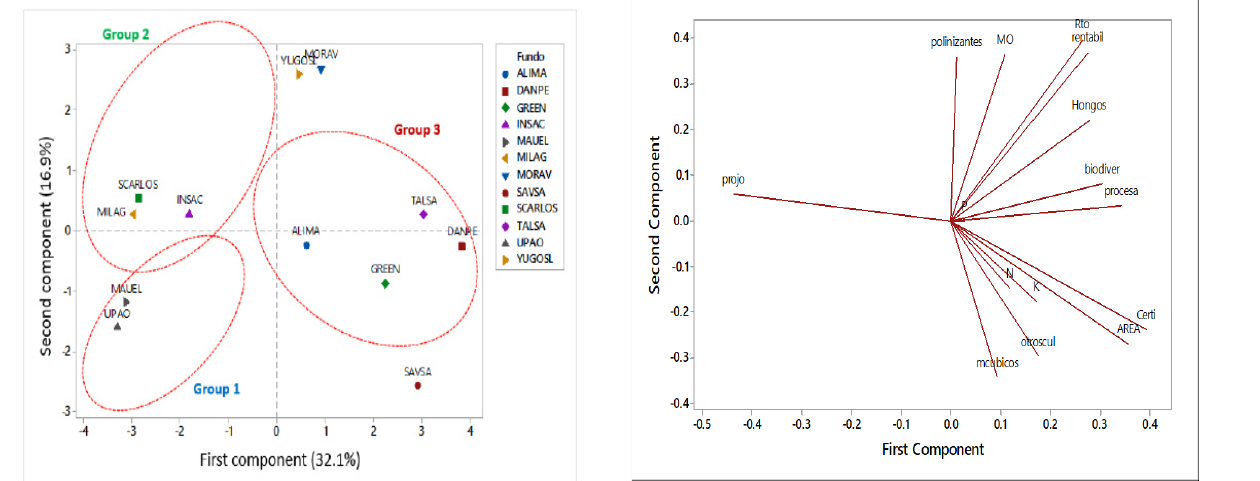
Figure 4. Biplot graph of the main components of the avocado plantation of the Chavimochic irrigation project in 2017.